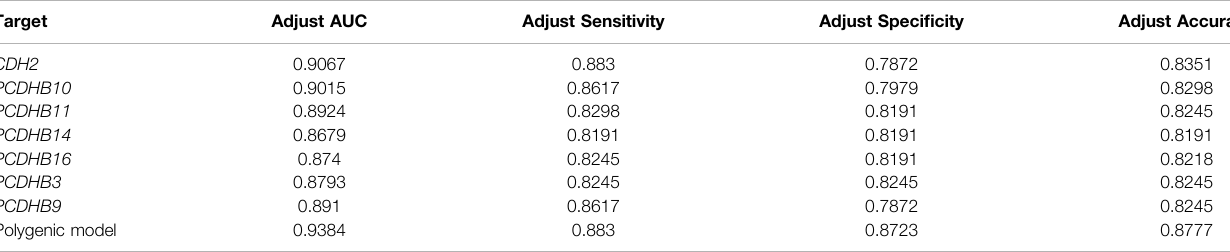
TABLE 8 | ROC analysis of 7 differentially methylated genes and polygenic methylation model. Target Adjust AUC Adjust Sensitivity Adjust Speci fi